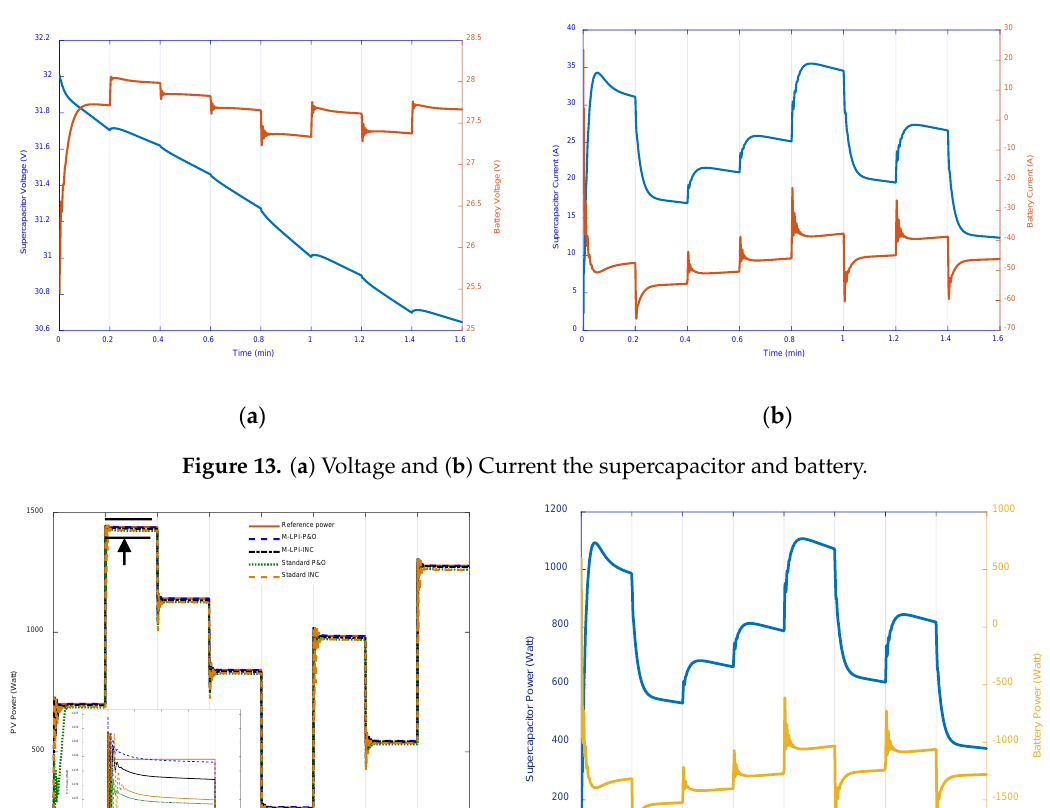
( b ) Figure 12. Photovoltaic ( a ) voltage and ( b ) current. Figures 13 and 14 present the variation of the voltage, current and power of the photovoltaic supercapacitor and battery, respectively. The first simulation starts at 500 W/m² solar irradiation and the supercapacitor is fully charged at 100%, while the battery is at 50%. The variation in the current, voltage and power (of the photovoltaic array, supercapacitor, and battery) are related to the solar irradiation variation, as given in Figure 11. The negative energy in the battery indicated that the photovoltaic array generated enough